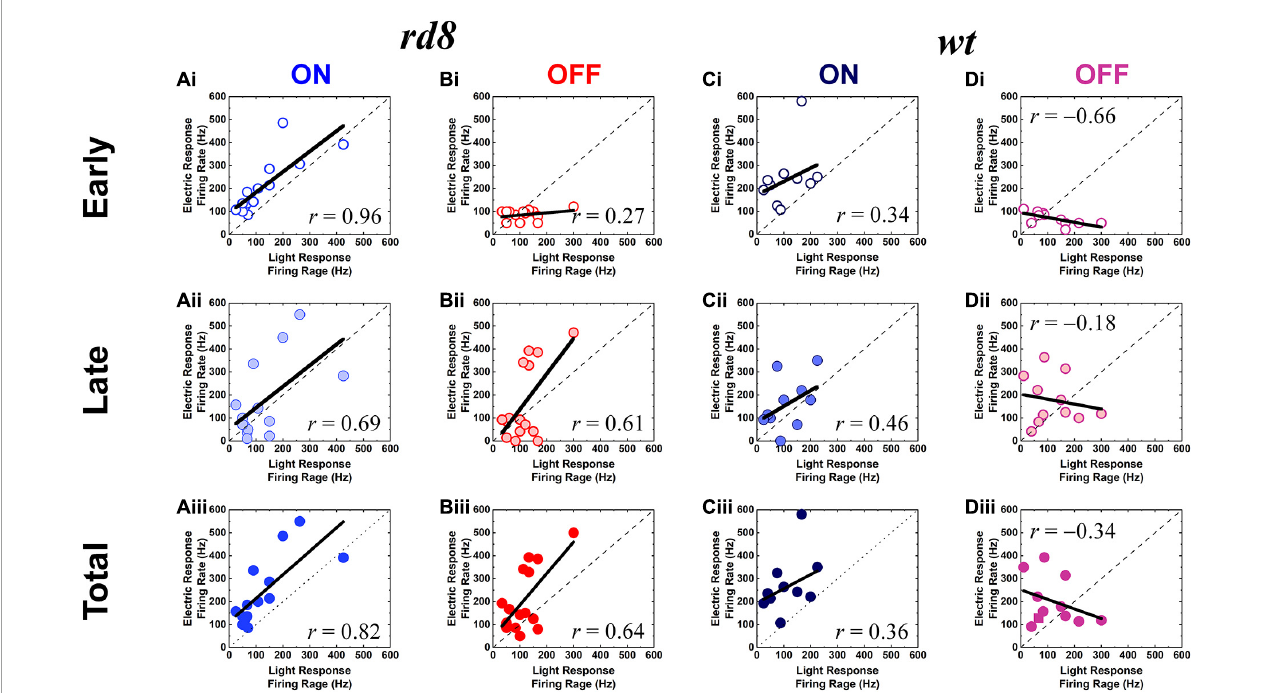
FIGURE5 Electric responses are well correlated with light responses in both ON and OFF RGCs of the rd8 retinas, and ON but not OFF RGCs of the wt retinas. (Ai–Aiii) Scatter plots of peak firing rate (PFR) for electric response vs. PFR for light response of the ON RGCs in the rd8 retinas. Scatter plots are shown for (Ai) early, (Aii) late, and (Aiii) total response, respectively. Each data point is from a different cell. Dashed line indicates linear fitting curve of all data points, and the level of correlation ( r -value) is shown in each plot. (Bi–Biii) Same as panels (Ai–Aiii) but for the OFF RGCs in the rd8 retinas. (Ci–Ciii) Same as panels (Ai–Aiii) but for the wild-type ( wt ) mouse retinas. (Di–Diii) Same as panels (Bi–Biii) but for the wt mouse